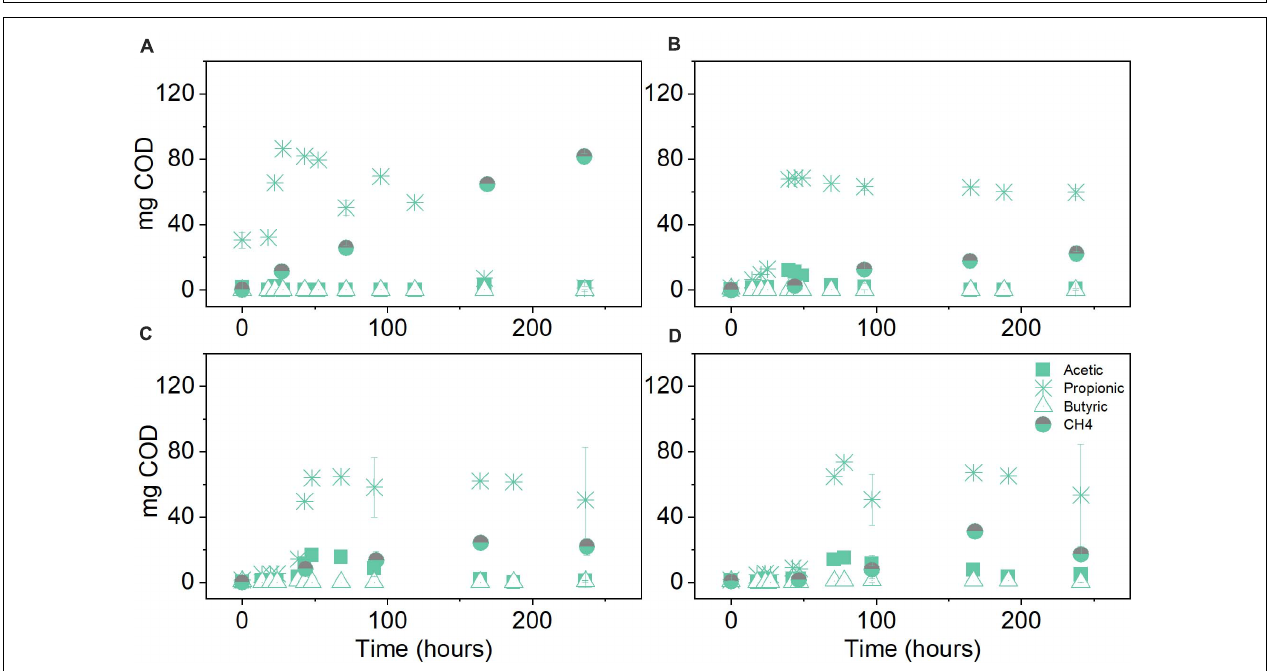
FIGURE 6 | Heatmap presenting the relative abundance of (A) Bacterial community and (B) Archaeal community at the genus level. Experimental treatments correspond to glycerol conversion at elevated pCO 2 using original (0.3, 3, 5, and 8 bar) and evolved inoculum (5 bar–E5). I corresponds to the original inoculum and E to the evolved inoculum. Pressure corresponds to initial values before equilibrium.